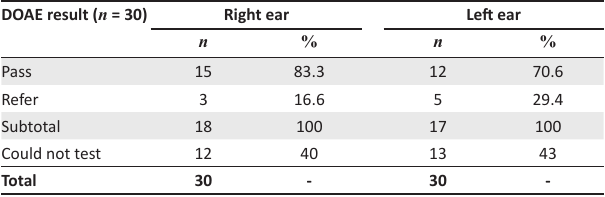
TABLE 4: Distortion product otoacoustic emission distortion product otoacoustic emissions